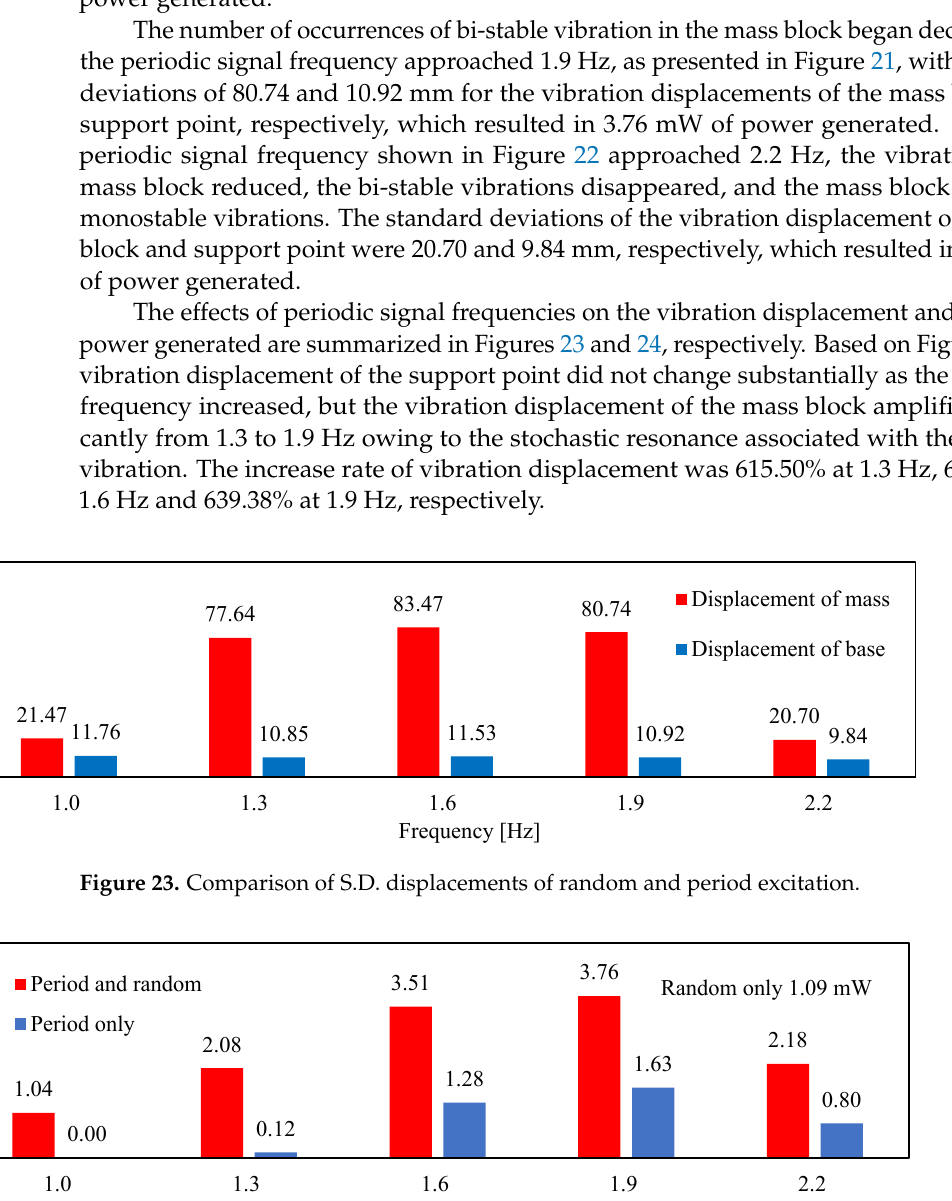
Figure 24. Effect of periodic excitation frequency on power output.